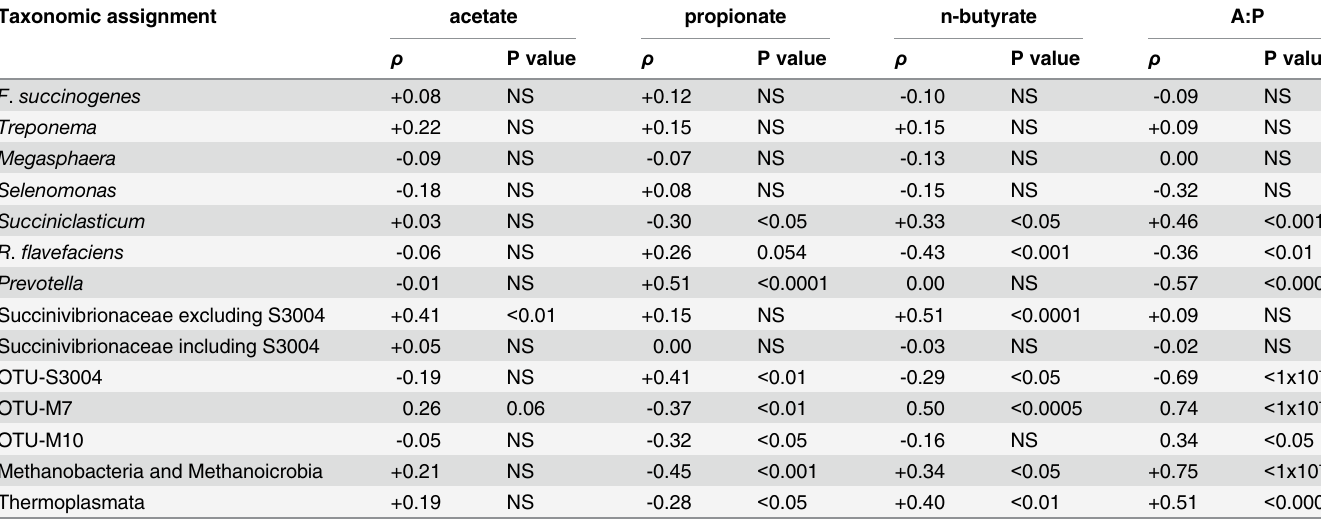
Table 1. Spearman correlation analysis between VFA and OTU-S3004, methanogenic archaea, and S and P producers in liquid rumen samples. Taxonomic assignment